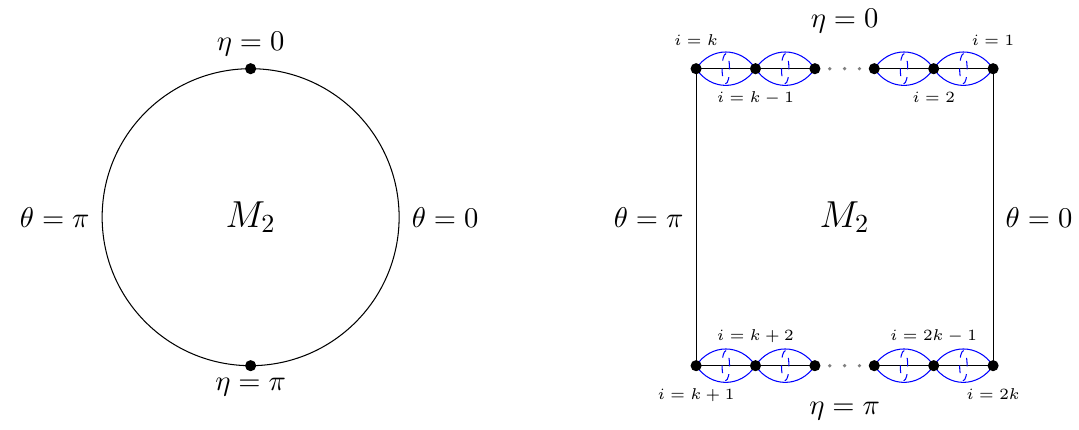
Figure 1 . Illustration of the topology of M 4 , with the ψ and ϕ angles suppressed, before ( left ) and after ( right ) the resolution of the orbifold singularities at η = 0 , π . We may roughly think of the coordinates η and θ as the 2d “latitude” and “longitude” respectively. The circle S 1 vanishes along ψ the entire boundary ∂M 2 , whereas S 1 vanishes only at the monopoles, which are labeled by the ϕ index i = 1 , . . . , 2 k . The blue bubbles overlaid on ∂M 2 depict the resolution two-cycles connected with unit-charge Kaluza-Klein monopoles after the orbifold singularities are blown